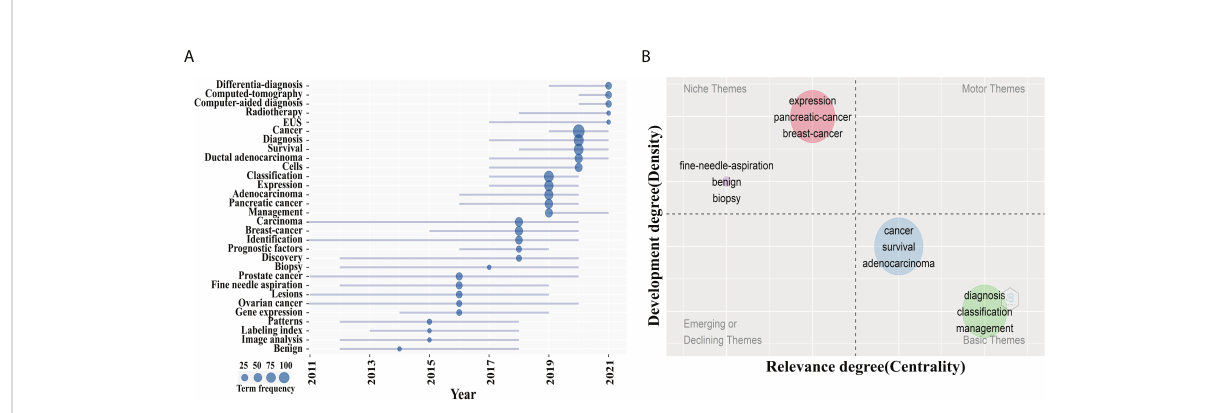
FIGURE 7 Theme analysis. (A) Trend topics map. The larger the circle is, the more occurrences keywords. (B) Thematic map of keywords plus. The x axis represented the centrality of a topic, which indicated the degree of interaction between network clusters in comparison to other clusters and provided information about its signi fi cance. The y axis showed the density that re fl ected the internal strength of a cluster network and may be considered as a measure of topic development. Keywords “ diagnosis “ , “ survival ” , “ classi fi cation ” , and “ management ” in quadrant 4 (Basic